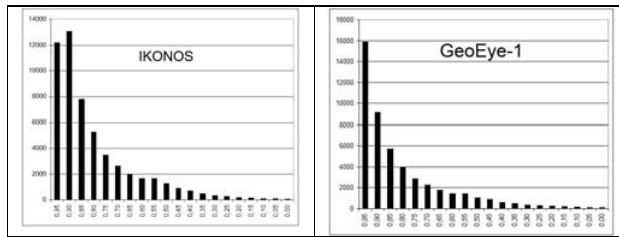
Figure 7: frequency distribution of correlation coefficients by LSM